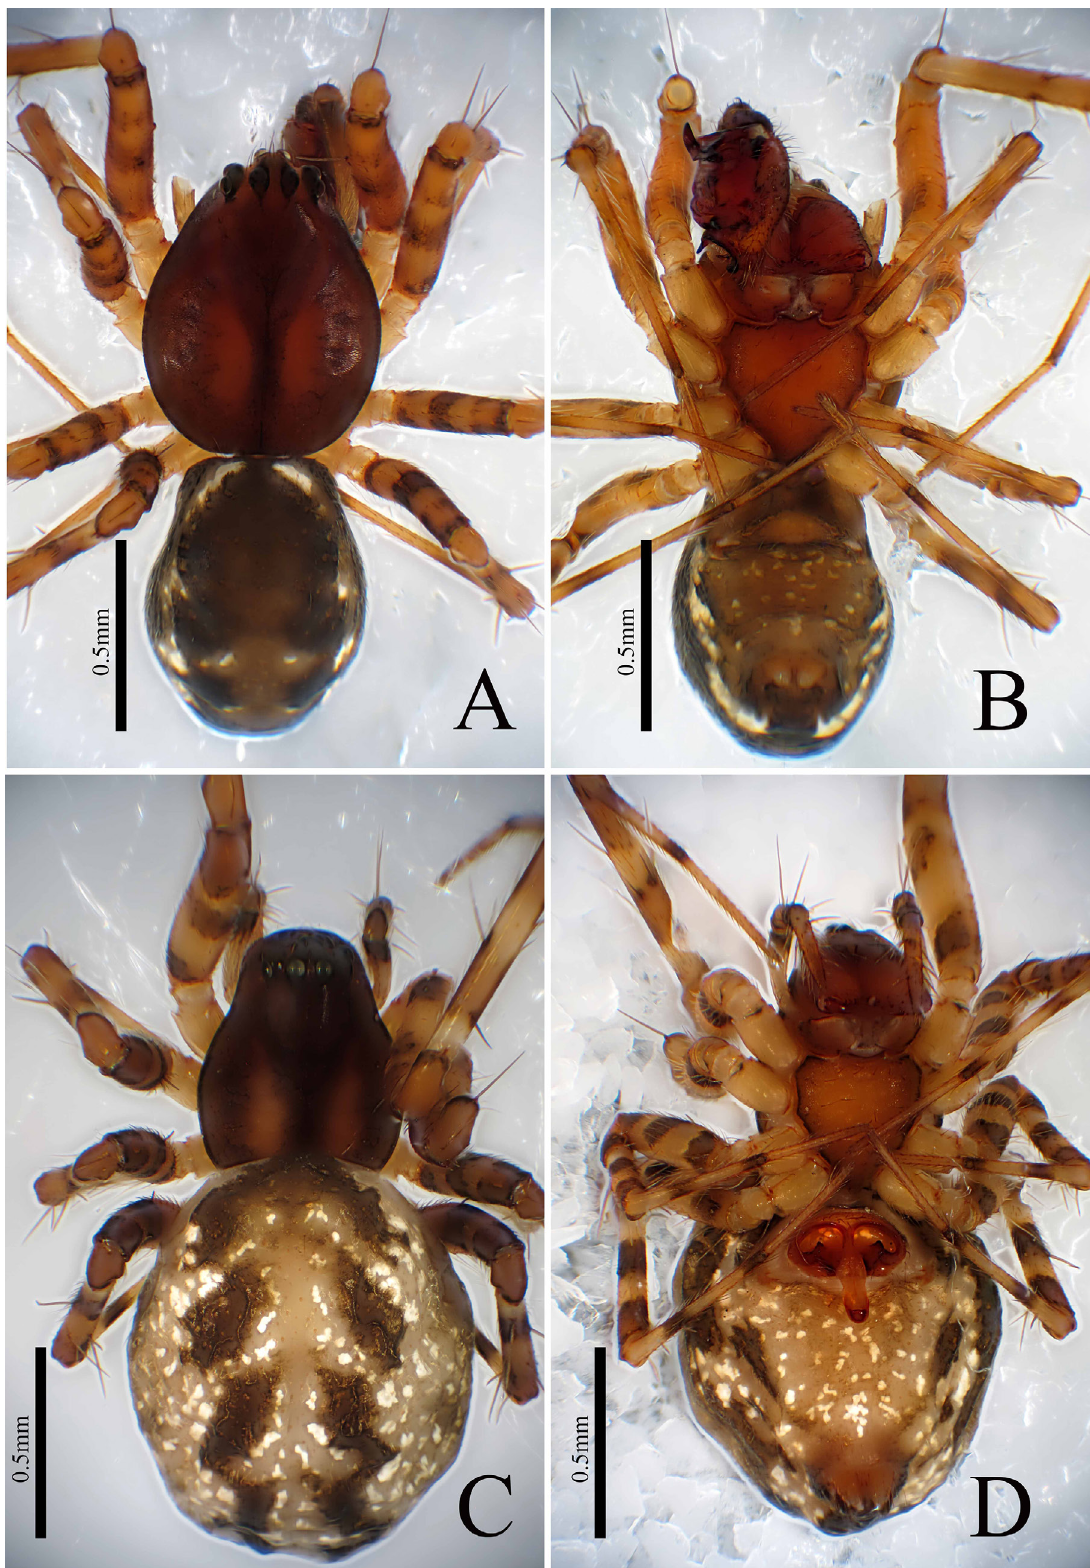
Fig. 28. Acroterius latus gen. et sp. nov. A–B . ♂, holotype (HNU-CGY123). C–D . ♀, paratype (HNU-CGY123). A , C . Habitus, dorsal view. B , D . Habitus, ventral